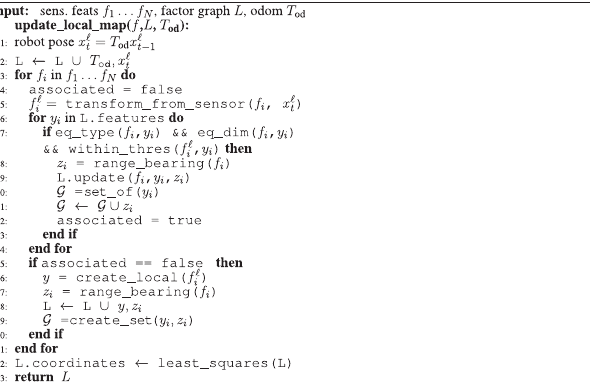
Algorithm 1. The algorithm used to update the local map features when a new set of sensor features has been extracted from a laser